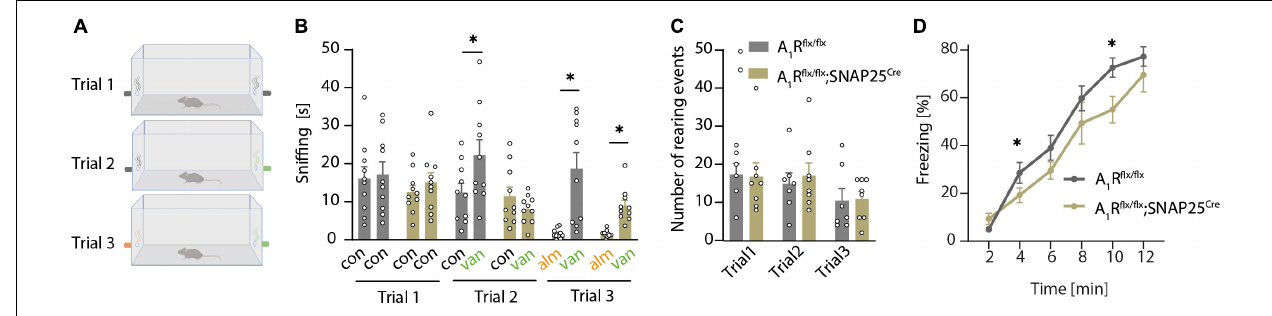
FIGURE 3 | A 1 R deficiency results in olfactory dysfunction. (A) Graphical workflow of olfactory detection test. A 1 R flx / flx and A 1 R flx / flx ;SNAP25 Cre were exposed to empty tubes (black), or tubes perfumed with a concentrate of vanilla (green) or almond (orange). Each trial lasted 4 min. (B) Quantification of olfactory detection tests. Preference to new odor analyzed by the time of sniffing at the respective side (s) ( n = 10 per group, BF 10 = 0.361). (C) Events of rearing during each trial in olfactory detection test of A 1 R flx / flx and A 1 R flx / flx ;SNAP25 Cre mice (BF 10 = 0.439–0.473). (D) TMT-based olfactory test. Time of freezing in percent in bins of 2 min in A 1 R flx / flx ( n = 11) and A 1 R flx / flx ;SNAP25 Cre ( n = 6). Bonferroni post-hoc test after a mixed multifactorial ANOVA; * P < 0.05.